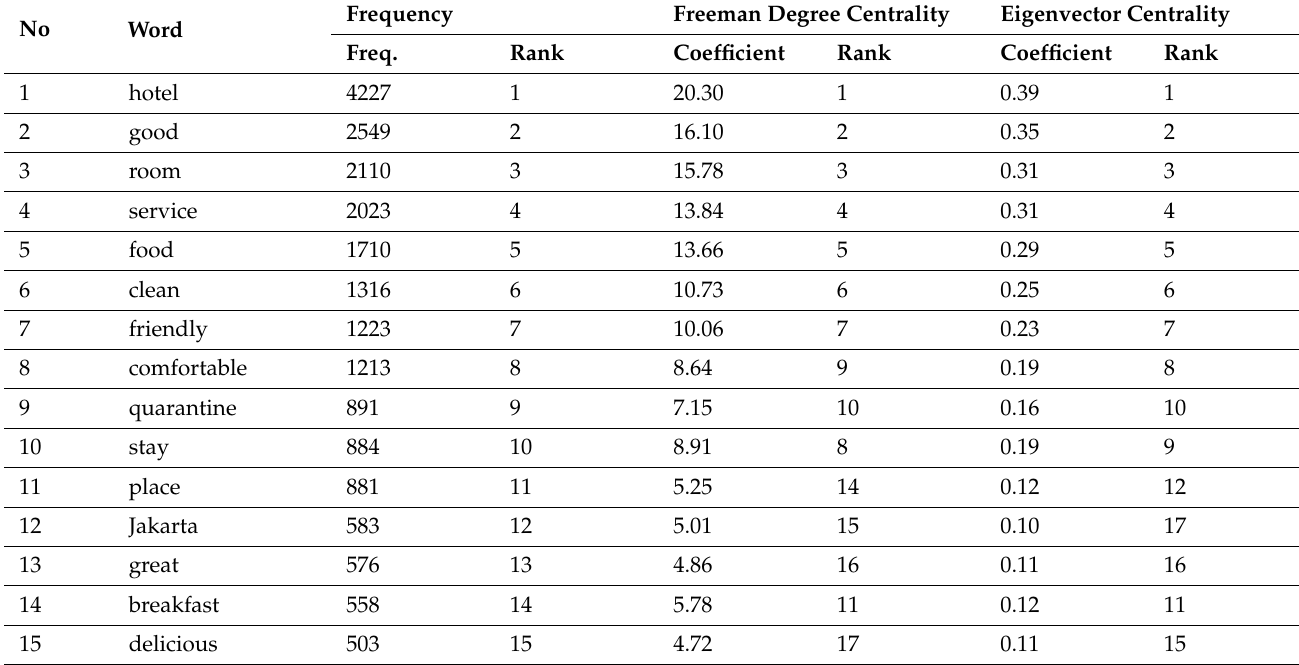
Table 5. Comparison of Frequency and Centrality of